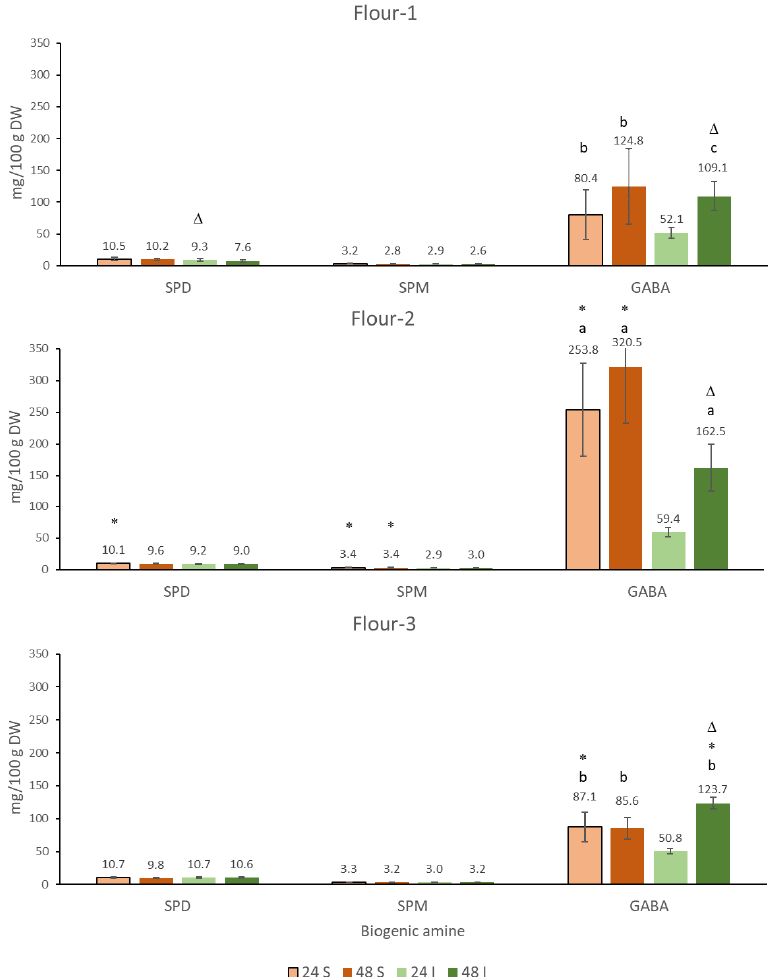
Figure 2. Spermidine (SPD), spermine (SPM), and gamma-aminobutyric acid (GABA) in chickpea sourdoughs from Flour-1, Flour-2, and Flour-3 prepared by spontaneous fermentation (S) and inoculated fermentation with commercially available starter culture (I) after 24 h and 48 h of fermentation at 30 °C. Differences in the content of particular compounds that are attributed to flour origin at fixed duration and type of fermentation are marked with different letters (a, b, c); different duration of fermentation at fixed flour origin and type of fermentation is marked with Δ ; type of fermentation at fixed flour origin and duration of fermentation is marked with *. The differences were significant at the p < 0.05 level.